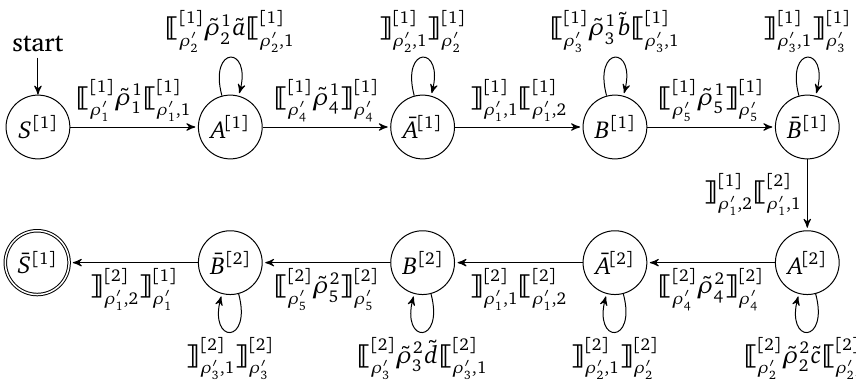
Figure 7: Modified generator automaton M ′ ( G ′ ) with respect to G ′ from Example